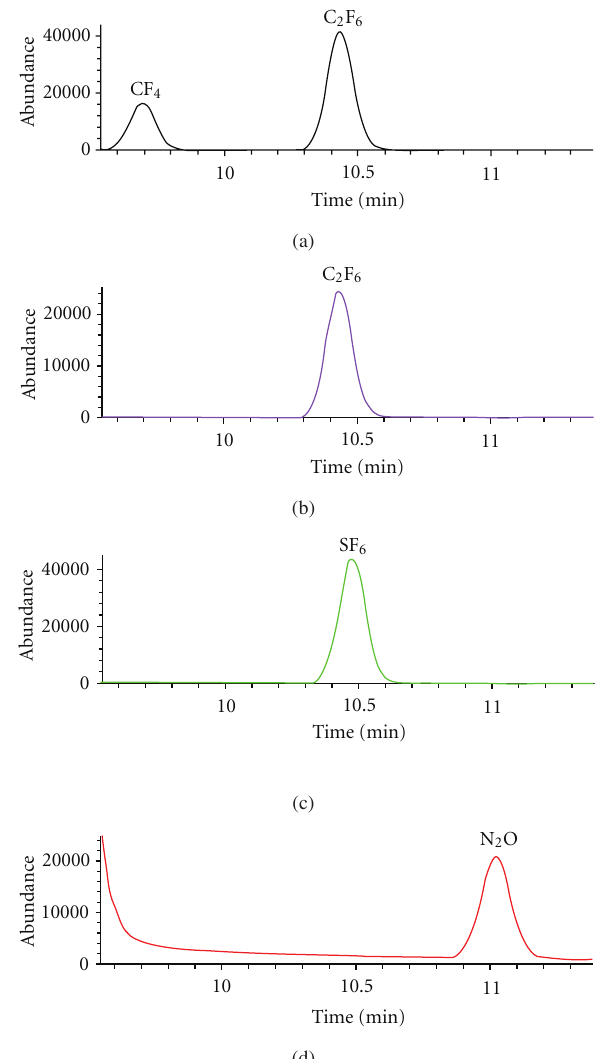
FIGURE 6: TD-GC/MS (SIM monitoring) chromatograms. Extracted-ion spectra for (a) CF 4 (m/z 69, CF 3 ); (b) C 2 F 6 (m/z 119, C 2 F 5 ); (c) SF 6 (m/z 127, SF 5 ); (d) N 2 O (m/z 30, NO) from a full-scan analysis of 25 mL of a 100 ppb gas standard